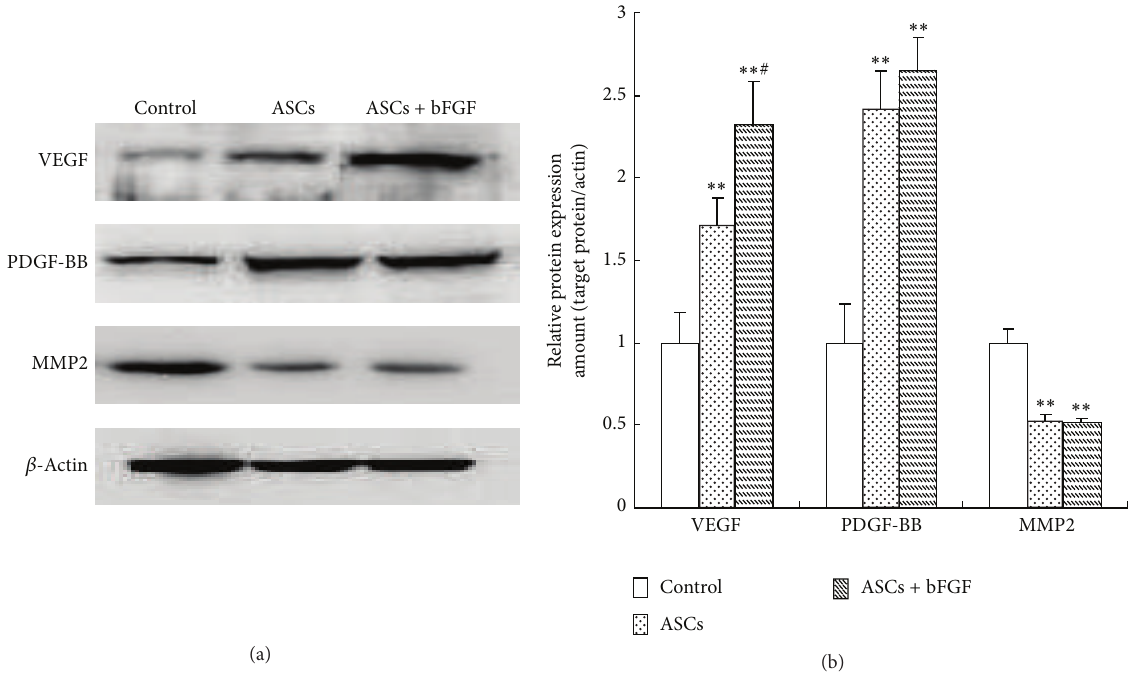
Figure 4: (a) Western blotting analysis of the expression of VEGF, PDGF-PP, and MMP2 in fat grafts. (b) Quantitative analysis of protein levels by densitometry. The data from western blot were normalized by taking the value of control group as 1. ∗∗ 𝑃 < 0.01 versus control group; # 𝑃 < 0.05 versus ASCs